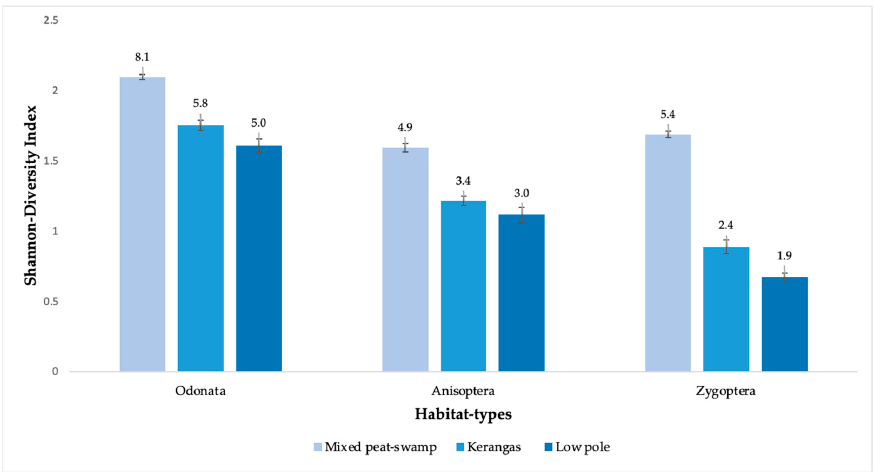
Figure 2. Shannon-diversity Index (H’)—Odonata (which includes both Anisoptera and Zygoptera) (left), Anisoptera (middle), and Zygoptera (right) for habitat-types mixed peat swamp, kerangas, and low pole forests. Effective number of species (ENS) values are given above each respective bar.